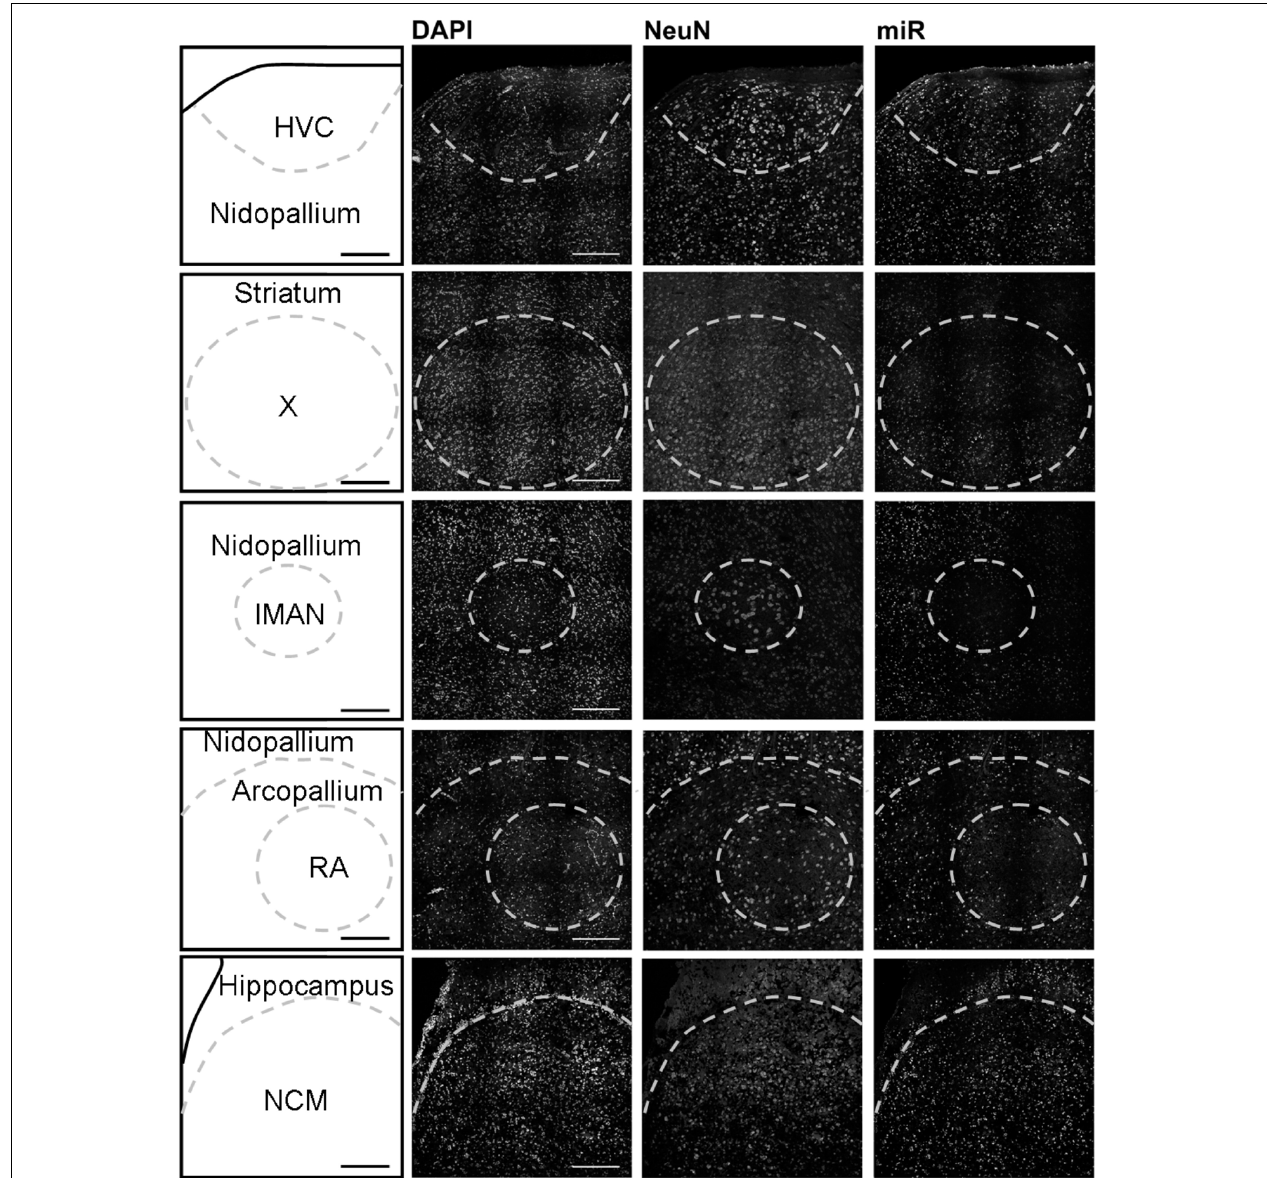
FIGURE 2 | Mapping of miR-2954 expression in zebra finch song nuclei (overview). Low-magnification view of miR-2954 expression in HVC, Area X, the lateral magnocellular nucleus of the anterior